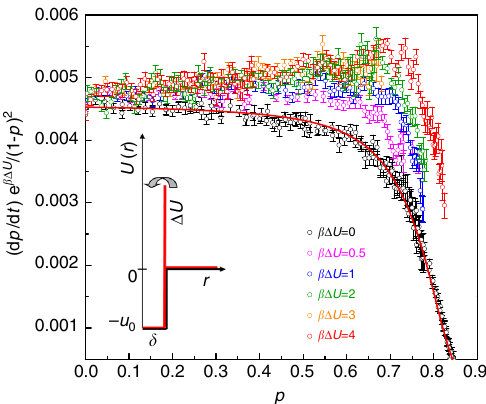
Fig. 2 Kinetics of autocatalytic reactions. Kinetic curves, p versus time, at Fig. 3 Barrier effect. Reaction rate d p /d t scaled by (1 − p ) 2 e − β Δ U , for fi xed temperature and energy barrier ( β Δ U = 4) for different values of different values of energy barrier, as indicated. For each β Δ U , symbols 0 autocatalytic strength ξ , as indicated. Time is scaled by e β Δ U 0 to highlight are mean ±SEM of the results of 40 independent simulation runs. The speed-up of the reaction due to autocatalysis. The pro fi le of the site – site solid line is the description of the data in the case without barrier, using potential for bond formation, including its qualitative behavior during reaction, is sketched in the inset as a function of the inter-site distance r -dependent average diffusion coef fi cient of a particle in the system (Methods section) (see next Fig.